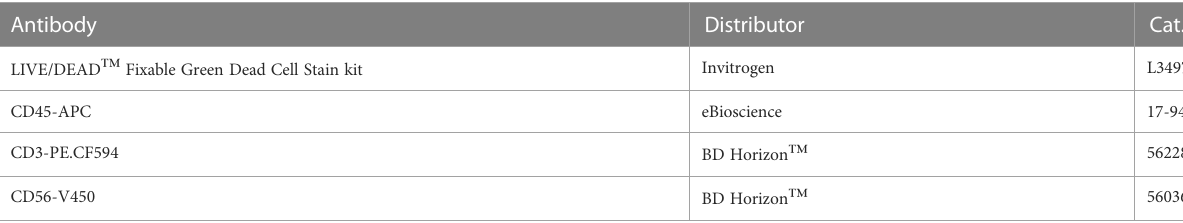
TABLE 1 Antibodies used for Natural Killer cells FACS